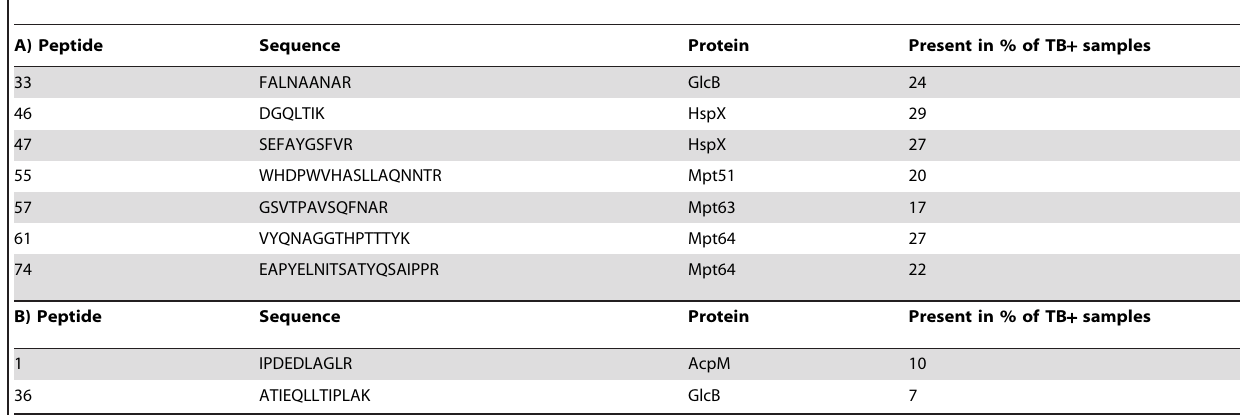
Table 3. Peptides specifically detected in active TB